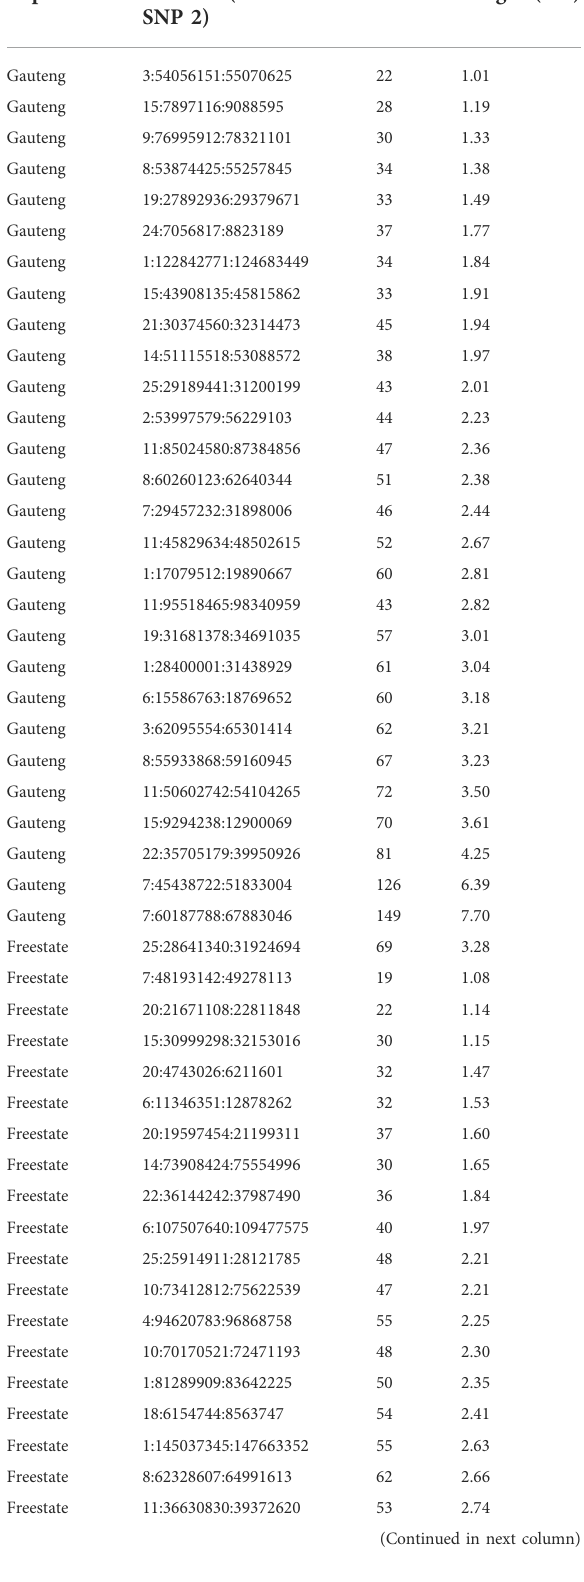
TABLE 3 Regions of the ROH islands at 20% across Gauteng and Free State populations by